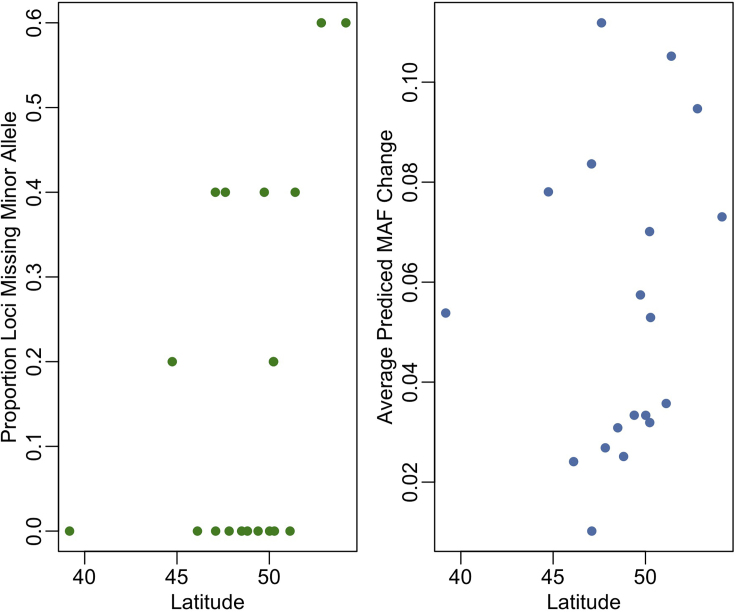
The Proportion of Loci Missing the Minor Allele and the Average Predicted MAF Change by LatitudePlots of (A) the proportion of loci that have only one allele by population and (B) the average project MAF change by population. Both are plotted against population latitude.